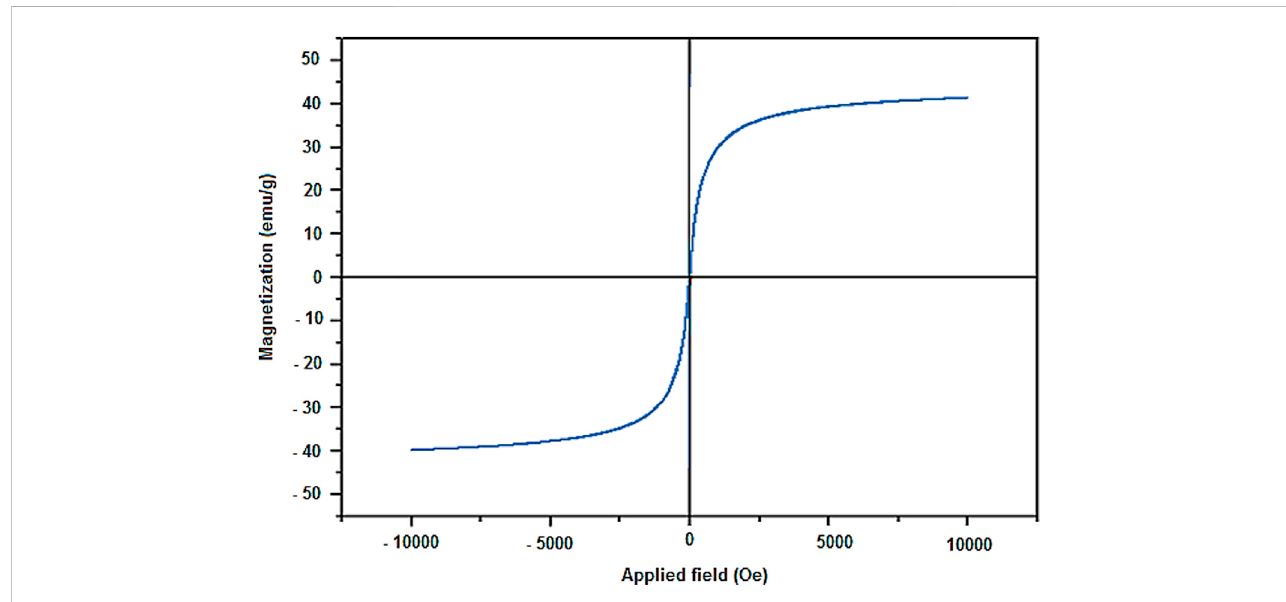
FIGURE 7 VSM analysis of Fe 3 O 4 @PMO/SB-Pd.